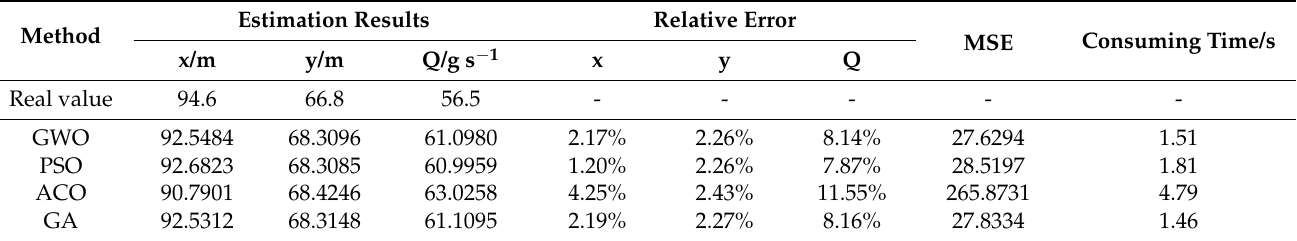
Table 2. Source estimation results of different methods for run